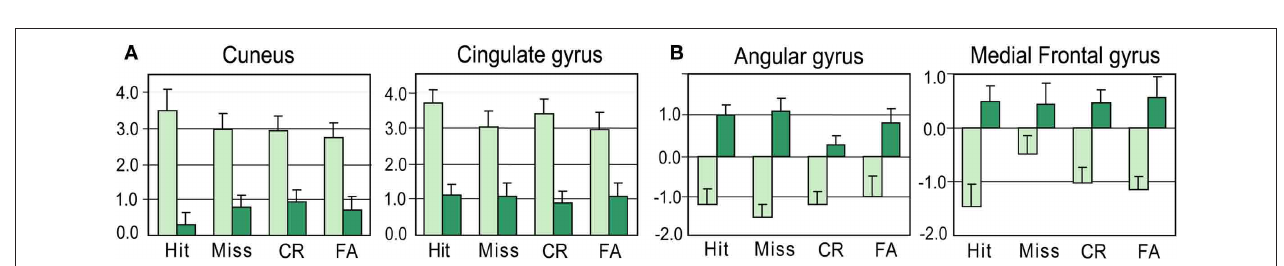
FIguRe 5 | rCBF differences found in the right piriform cortex and the left perirhinal cortex. The statistical parametric mapping (SPMs) are superimposed on coronal sections of a Tl-weighted scan. Graphs: level of activations for Hits, Misses, CR, and FA in young and elderly subjects in the right piriform cortex and in both groups in the left perirhinal cortex. Vertical bars, standard errors of the mean; * p < 0.05.